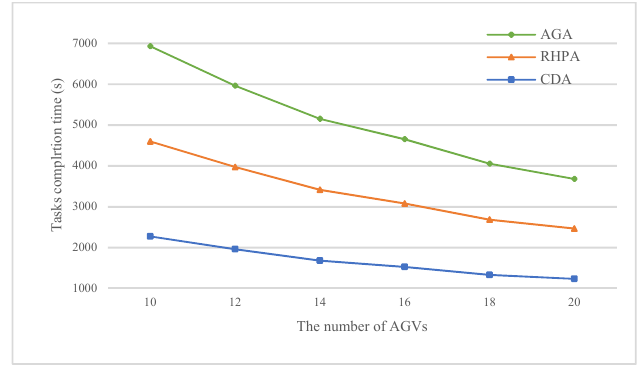
Figure 12. Curve of AGVs travel time with the number of AGVs.